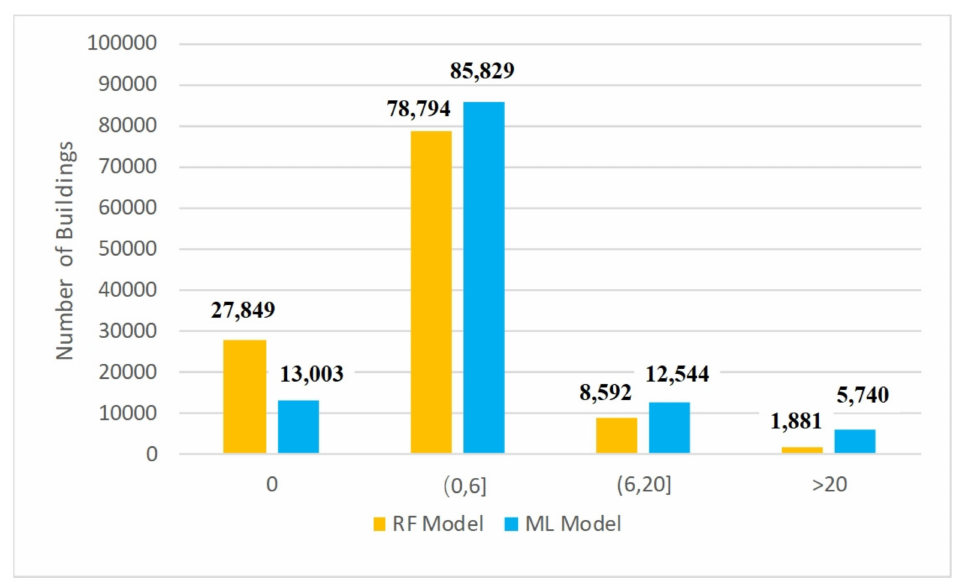
Figure 11. Histogram of error comparison between the RF model and ML